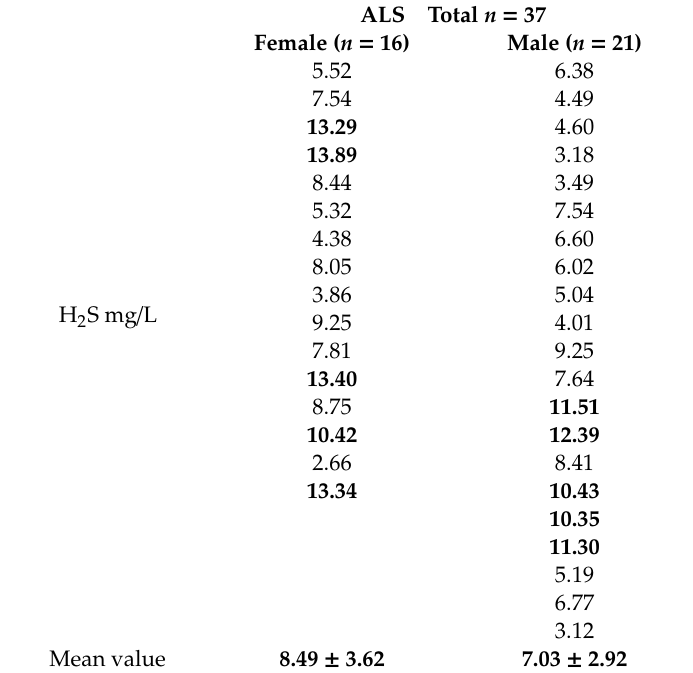
Table 1. Split analyses of the H 2 S content in male and female ALS patients.